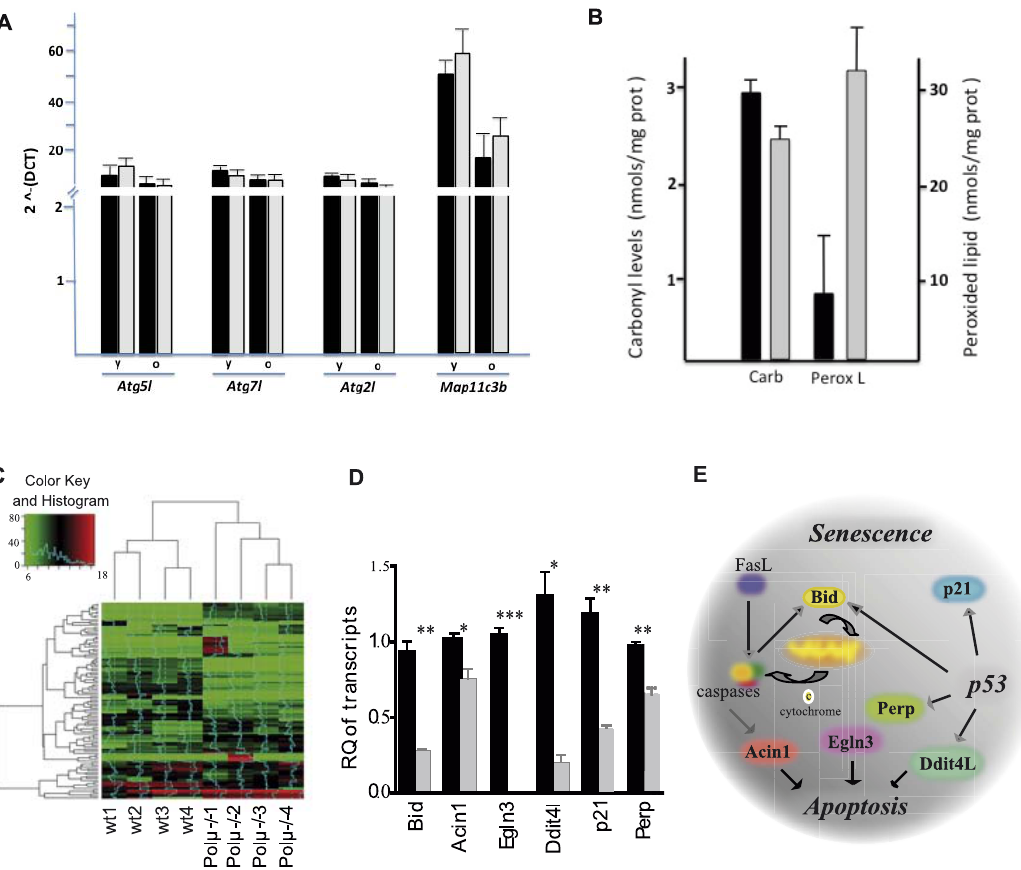
Figure 3. Liver from old Pol m 2 / 2 mice shows fewer aging-related features than liver from age-matched wt controls. ( A ) Involvement of autophagy activity in the Pol m 2 / 2 lifespan extension phenotype. Heart samples from old (18–25 m; o) and young (8–12 w; y) Pol m 2 / 2 (gray bars) and wt mice (black bars) were analyzed by qRT-PCR for the expression of a panel of genes essential for autophagy (Atg2l, Atg5l, Atg7l and Map11c3b). Results, expressed as 2 ‘ –(DCT), show mean values 6 SD (n=5). ( B ) Protein carbonyls (Carb) and peroxided lipids (PeroxL; thiobarbituric acid reactive substances, TBARS), as macromolecular oxidative damage, were determined (nmol/mg prot), as described in the supporting information, in perfused liver of old ( . 20 months) Pol m 2 / 2 (black bars) and wt gray bars) mice Results are mean values 6 SD (n=3). ( C ) Heat map of microarray expression data for livers from adult (14 m) wt and Pol m 2 / 2 mice. The relative gene expression scale is shown, with normalized scores ranging from 0 to 20. Gene cluster and case cluster dendrograms are plotted to the top and left. ( D ) Microarray data validation. mRNA levels were determined by TaqMan RT-PCR in livers from adult wt (black) and Pol m 2 / 2 mice (gray). Each determination was performed in triplicate and normalized to b -actin expression. Data are the means 6 SEM of 4 samples per genotype, represented relative to expression in age-matched wt liver. ( E ) Scheme of the interaction network among apoptosis-related or p53-inducible genes downregulated in old Pol m 2 / 2 liver.